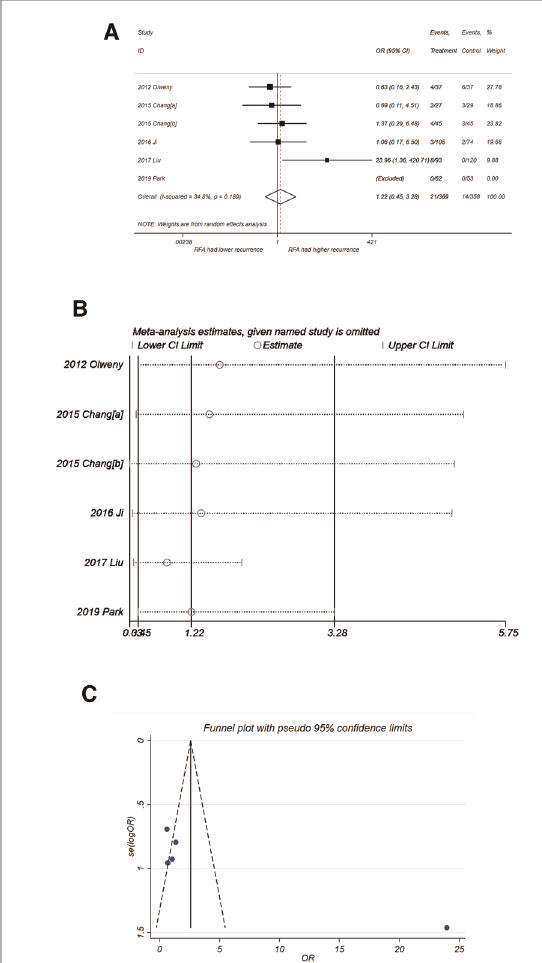
FIGURE 3 Comparison of recurrence incidence of RFA vs. PN. ( A ) The forest plot shows the OR (odds ratio) of recurrence incidence of RFA vs. PN. OR>1 indicates that RFA has higher probability of recurrence. ( B ) Sensitivity analysis was performed by omitting one study at each analysis. The result of each analysis is also presented as the forest plot. ( C ) The funnel plot was used to detect publication bias. RFA, radiofrequency ablation; PN, partial nephrectomy; OR, odds ratio.